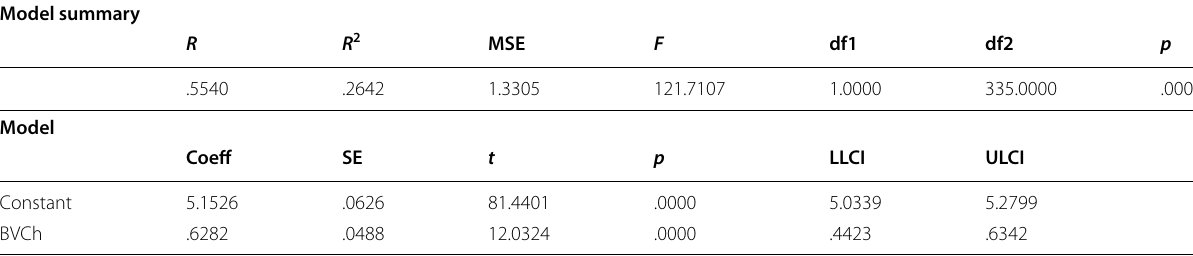
Table 8 The output of brand resonance. Source: Author’s calculations using Hayes Process Macro Model 5